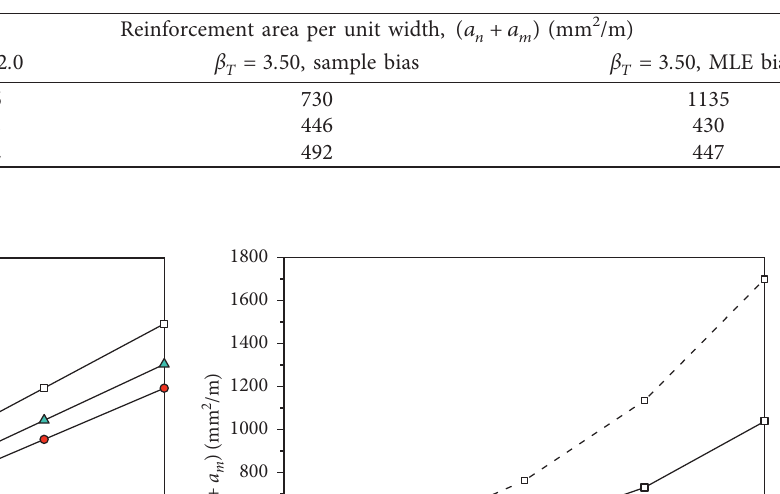
+ a ) against FS ranging from 1 to 5 and β n m